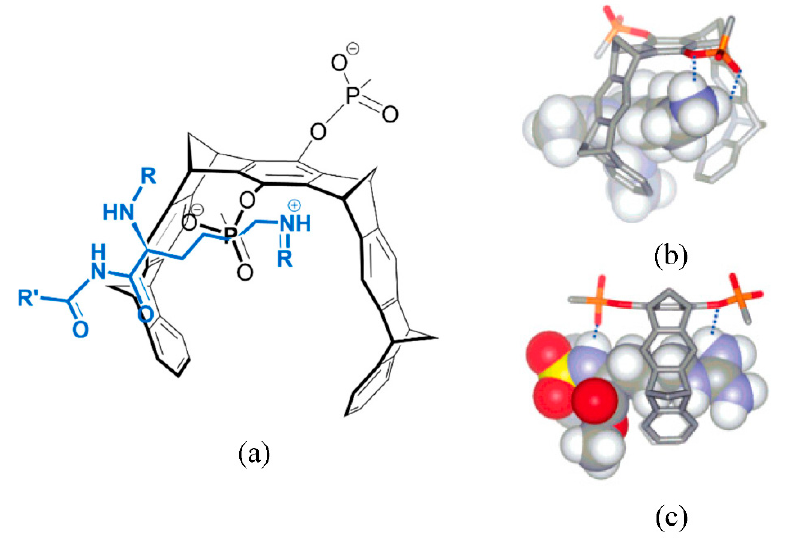
Figure 16. ( a ) Proposed structure adapted from Fokkens et al. and Monte Carlo simulations of the complexes between MPnT and Ac-Lys-OMe ( b ) and Ts-Arg-OEt ( c )—MacroModel 7.1, Amber*, water, 5000 steps. Reprinted from [24] with permission. Copyright (2005) American Chemical Society.